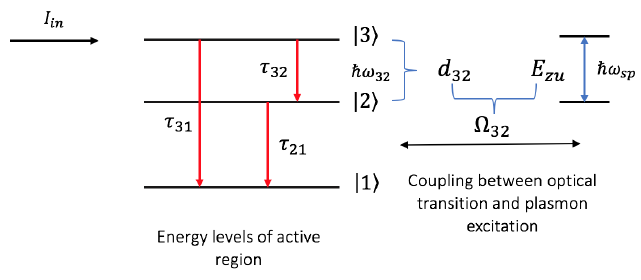
Figure 2. Model of the proposed MNPs-GNDs-QDs hybrid-system-based